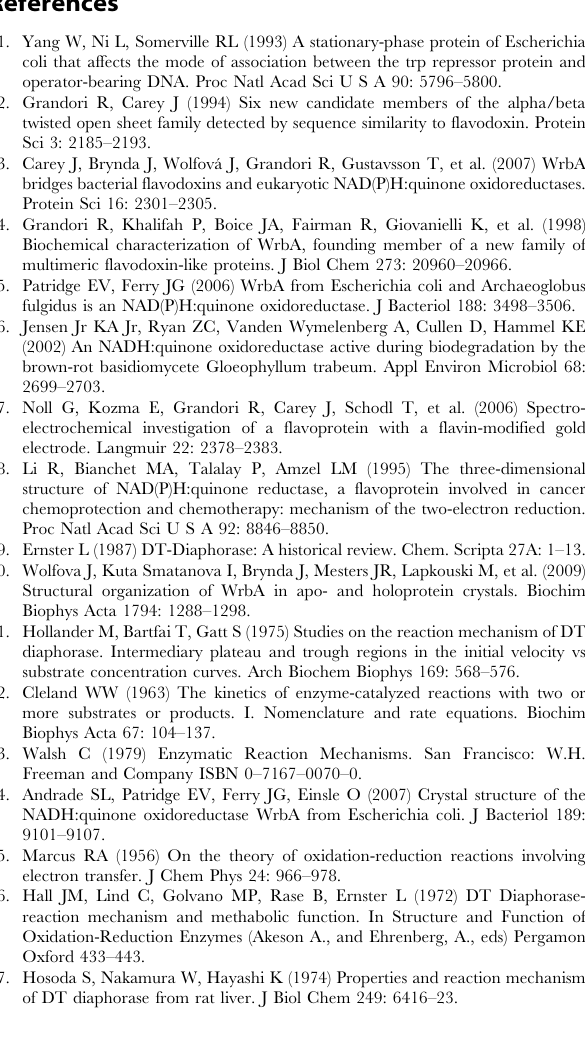
Figure S2 Kinetics of WrbA at high concentrations of NADH or BQ. Assays were carried out at 23 u C to limit the reaction to a single kinetic phase. Figure S3 Product inhibition of WrbA. Each pair of plots shows rectangular hyperbolic and linear representations of the same data set for the indicated concentrations of constant and variable substrates and inhibitors. Table S1 Ligand binding energies calculated by QM/ MM